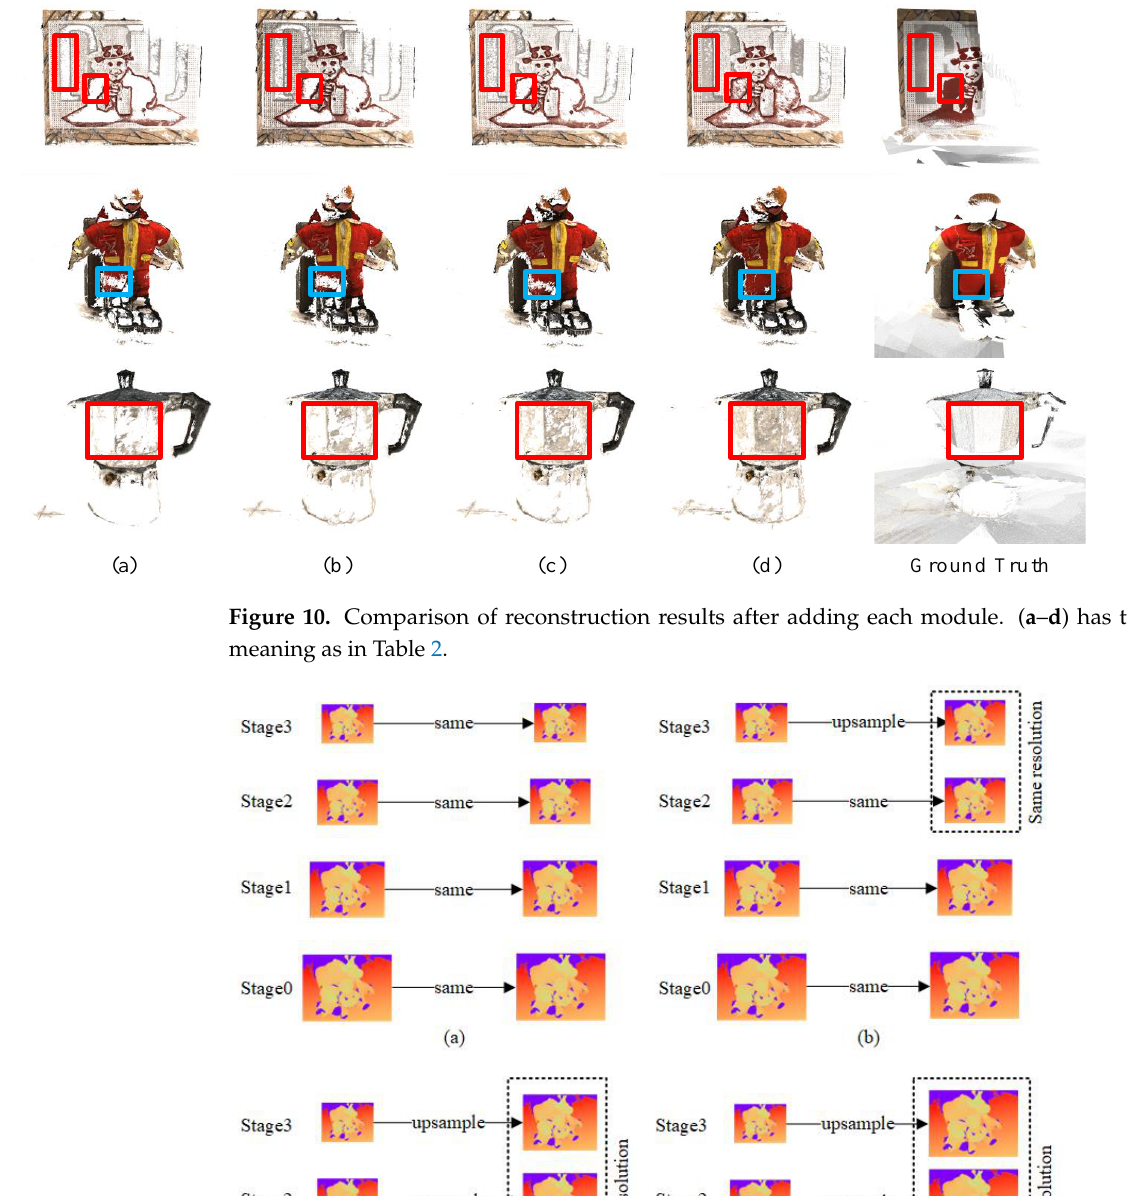
Table 3. Effect of different depth map adjustment methods. Method